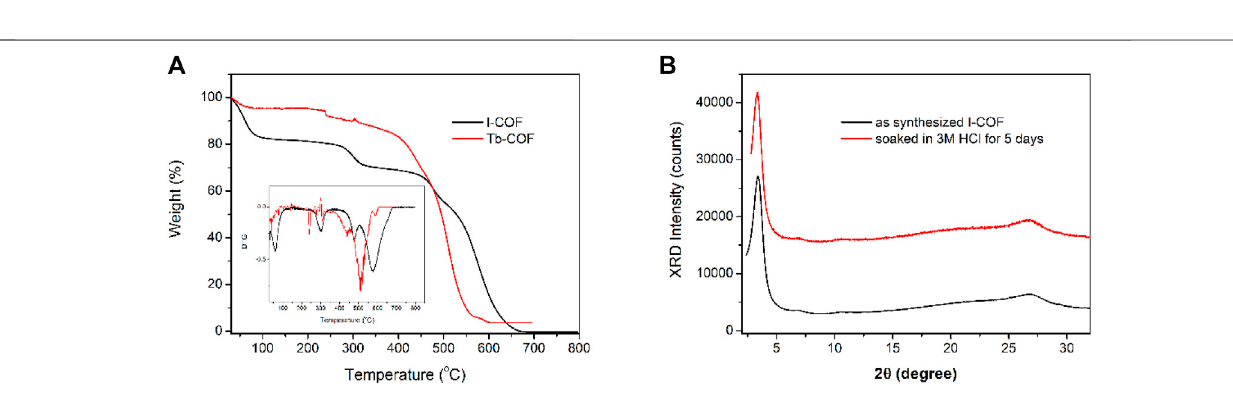
FIGURE 5 | (A) : TGA and DTG of I-COF and Tb-COF. (B) : XRD patterns of I-COF before and after being soaked in 3M HCl for 5